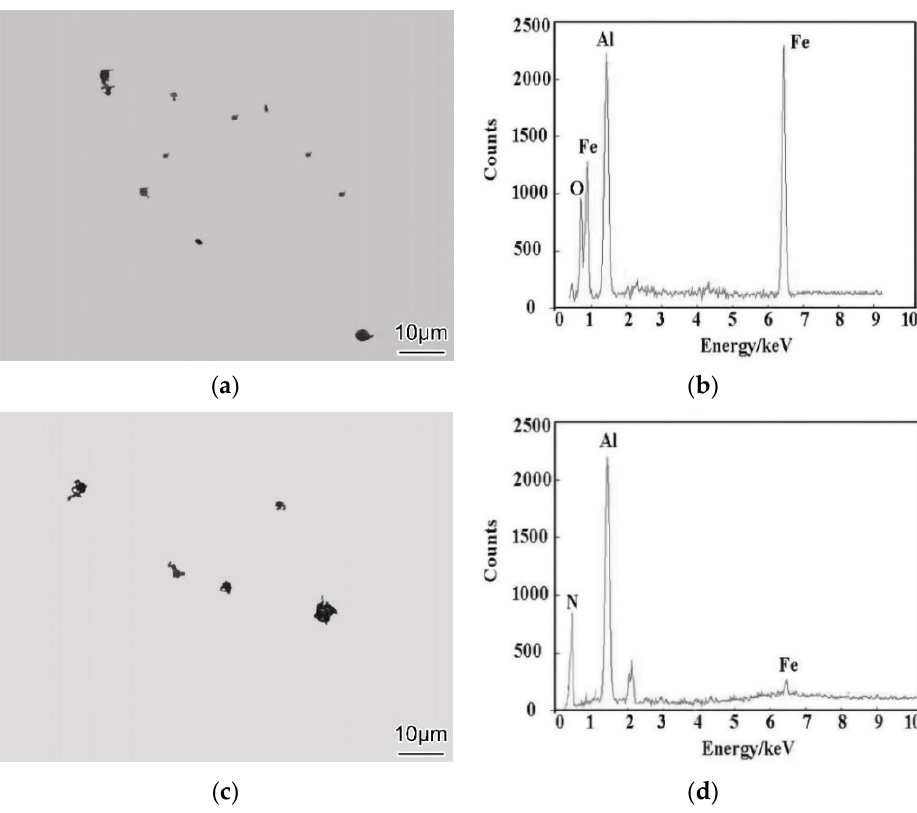
Figure 7. Morphology and energy spectrum analysis of inclusions: ( a ) 0.21%Al; ( b ) Al 2 O 3 energy spectrum; ( c ) 1.05%Al; ( d ) AlN energy spectrum.